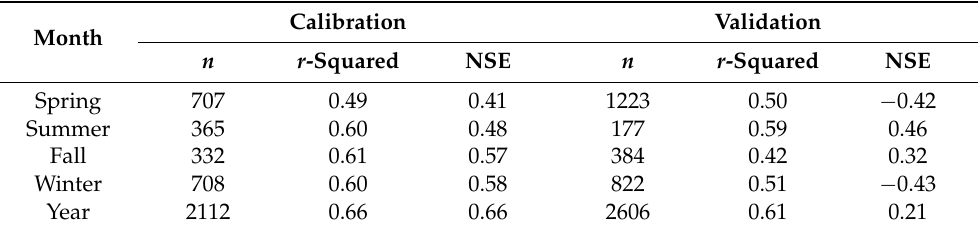
Table 2. Statistical results for calibration and validation of the deterministic DO